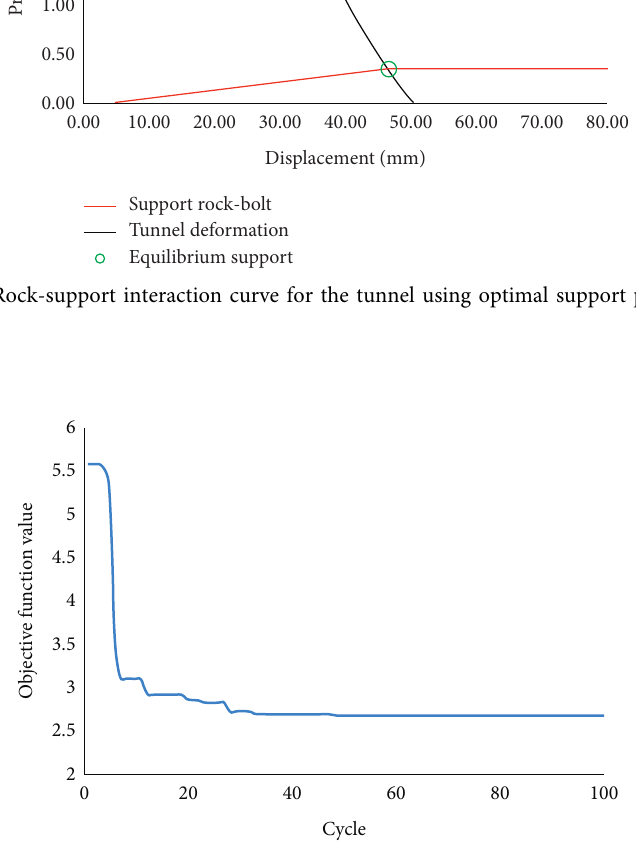
Figure 8: Relationship between the objective function value and the cycle of the